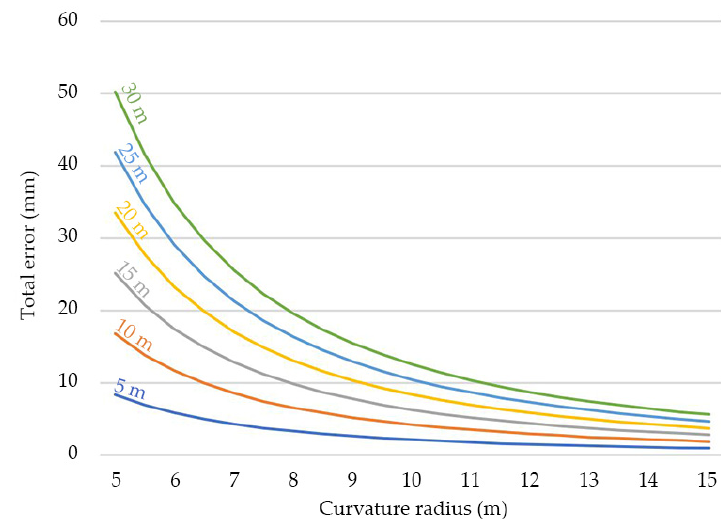
Figure 9. Compass Method error for a 1 m subdivision mesh.